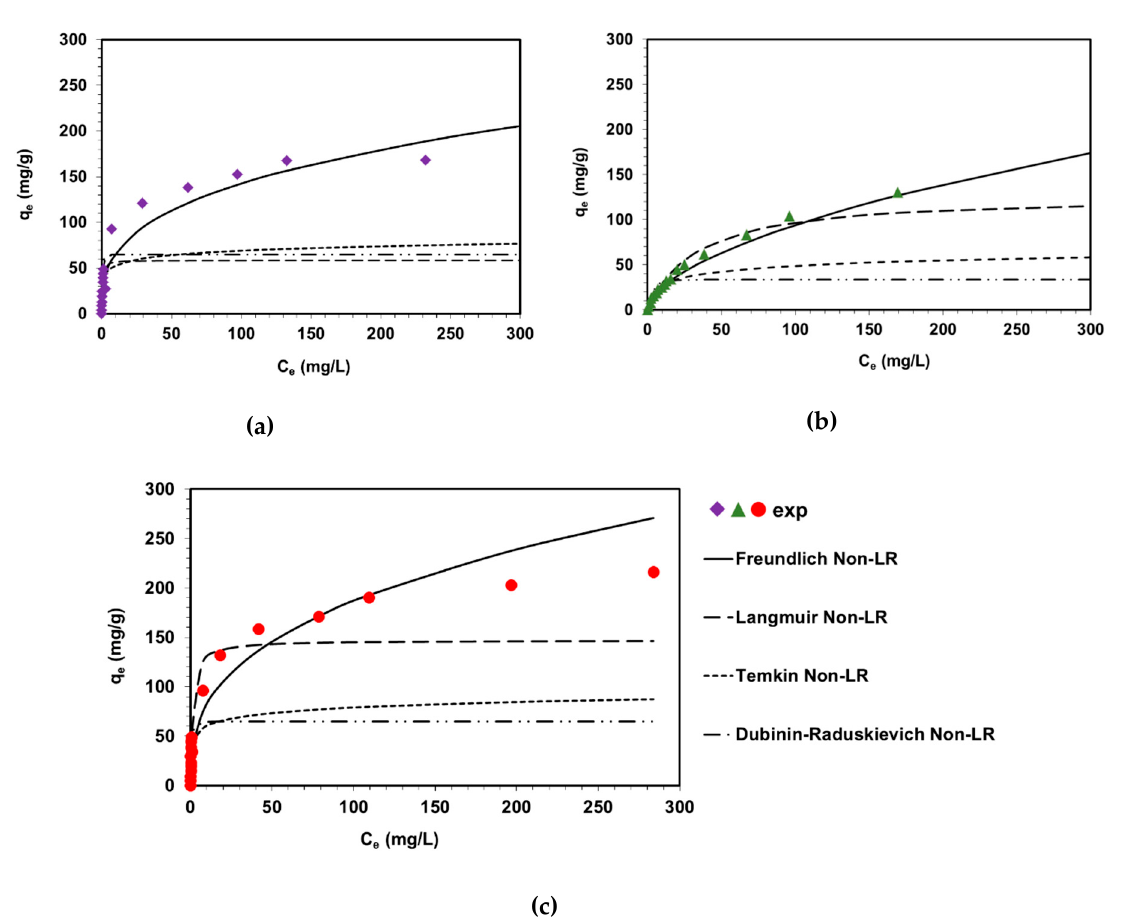
Figure 5. Adsorption isotherms of AV1 ( a ), AG16 ( b ) and AR18 ( c ) on DVB- co -GMA-TETA and fitting of the Langmuir, Freundlich, Temkin and Dubinin-Raduskievich to experimental data using non-linear regression (Non-LR).